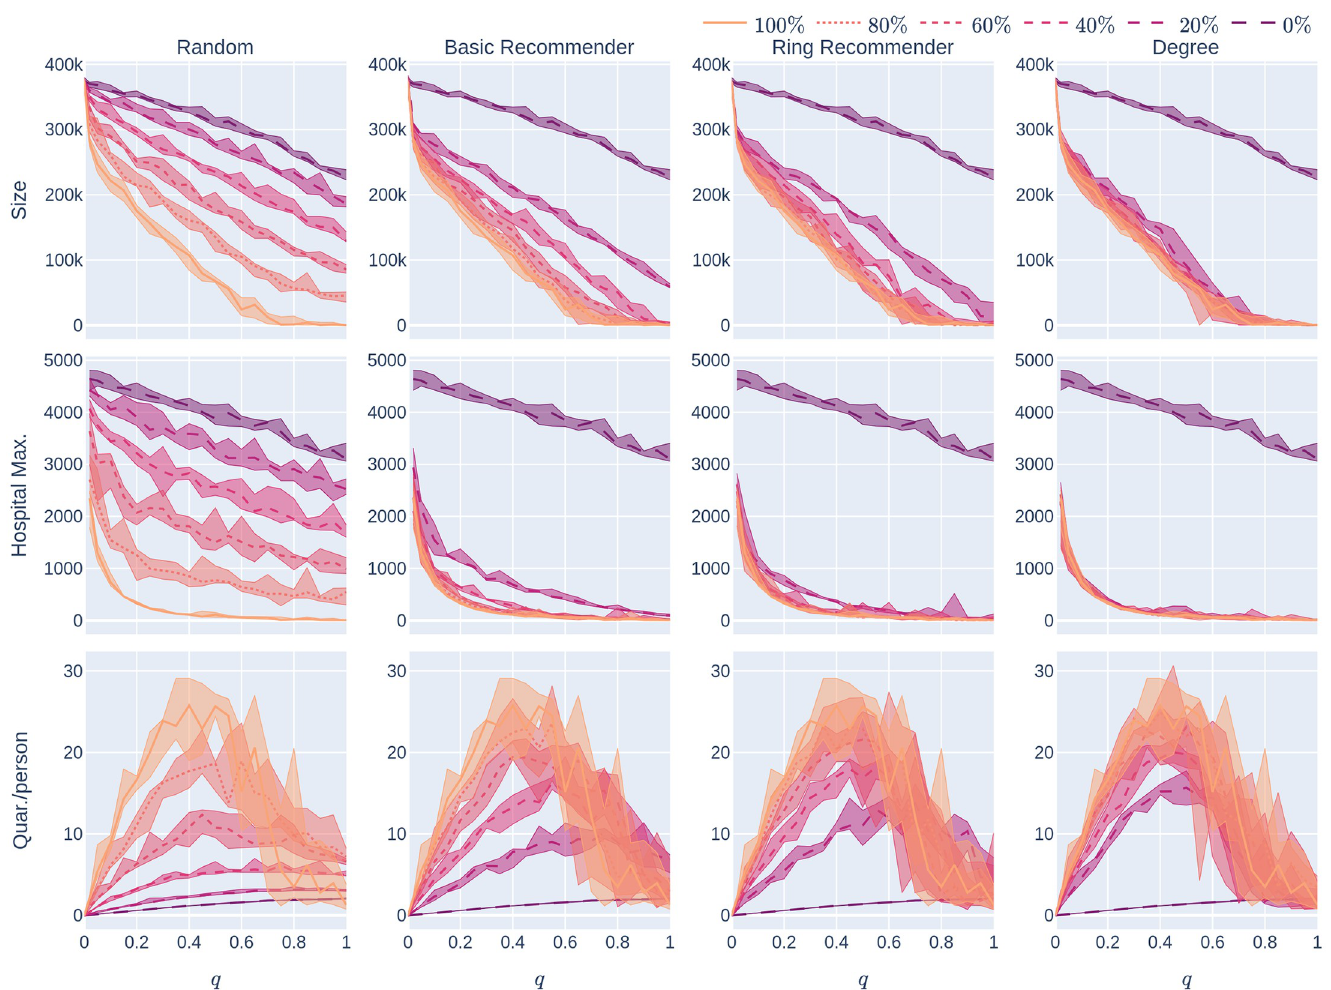
Fig 15. Experiment 2 on a more geometric network with many super-spreaders: Influence of the quarantine strictness q for various uptake percentages p % and the four uptake scenarios: The KPIs are plotted against q , the quarantine strictness. We work here with a fixed underlying network, a 500,000 node GIRG with τ = 2.3 and α = 2.3. Observe the similarity with Fig 14. Each column represents a given uptake scenario (random, basic-recommender and ring-recommender, and degree- targetted). Fig 13 below is qualitatively similar and considers an underlying network that is less geometric. The x -axis shows the quarantine strictness q varying from 0 to 1 at step size 0.05. Simulations are done for the 21 values of q corresponding to these steps. There is an additional simulation point at 0.02 (in order to avoid division by 0 in the computation for HMax and still have a point close to 0). The y -axis shows the corresponding value of the KPI. The curves on each figure correspond to the different uptake percentages, as labelled. For each parameter value, the plotted result is the median over 5 runs. The shaded region around the plot covers the results of all 5 simulations. The epidemic is started by infecting 100 individuals, chosen uniformly at random. Simulation is halted when there are no more exposed or infected vertices. The infection rate is β =